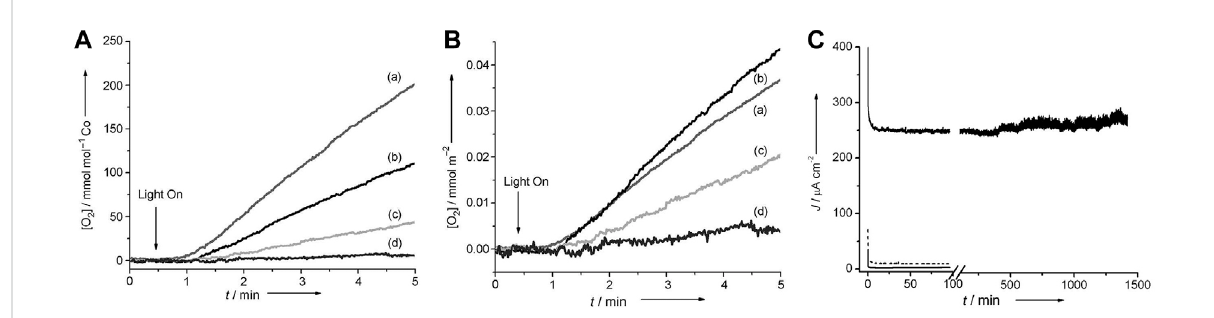
FIGURE 3 (A) Concentration of dissolved O 2 measured by a Clark-type electrode at 23 ° C, pH 5.8 for lithium cobalt oxides synthesized at (A) 400 ° C, (B) 500 ° C, (C) 600 ° C, and (D) 700 ° C, and (B) the total surface area of a synthesized catalyst. (C) Bulk electrolysis of the Na fi on-only control (solid gray line), 700-LiCoO 2 (dashed gray line), and 400-Li 2 Co 2 O 4 (solid black line). (Gardner et al., 2012) Copyright 2012, Wiley-VCH.